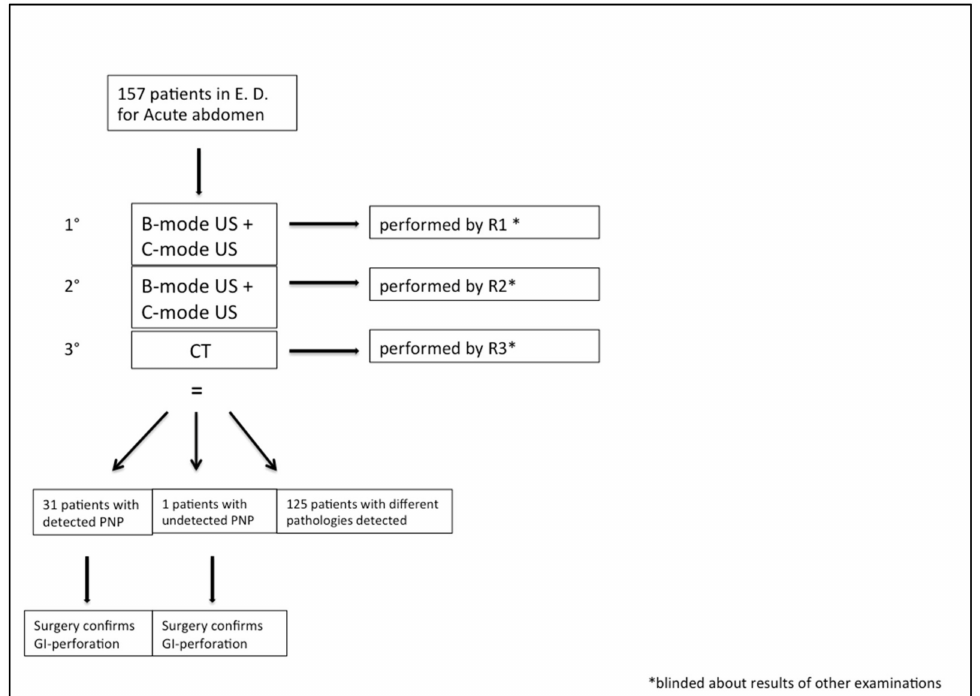
Figure 1. Study population design. According to the flowchart of the study procedure, all patients underwent B-mode, C-mode and CT examination, performed by three different radiologists (R1, R2, R3). At the end of the presented diagnostic course, PNP was correctly detected in 31 patients and missed in one patient. Successive surgical intervention confirmed the presence of PNP originated from gastro-intestinal perforation in 32 patients. * E.D. = emergency department. * R1, R2, R3 = radiologist 1, radiologist 2, radiologist 3. * C-mode = contrast-specific software mode. * PNP= pneumoperitoneum. 1 ◦ ,2 ◦ ,3 ◦ = first step, second step, third step of